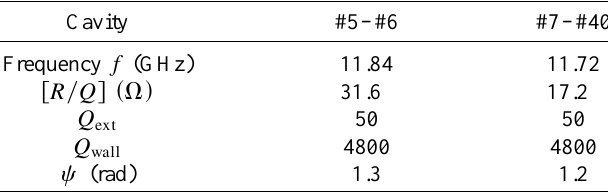
TABLE II. Design parameters of main TBA